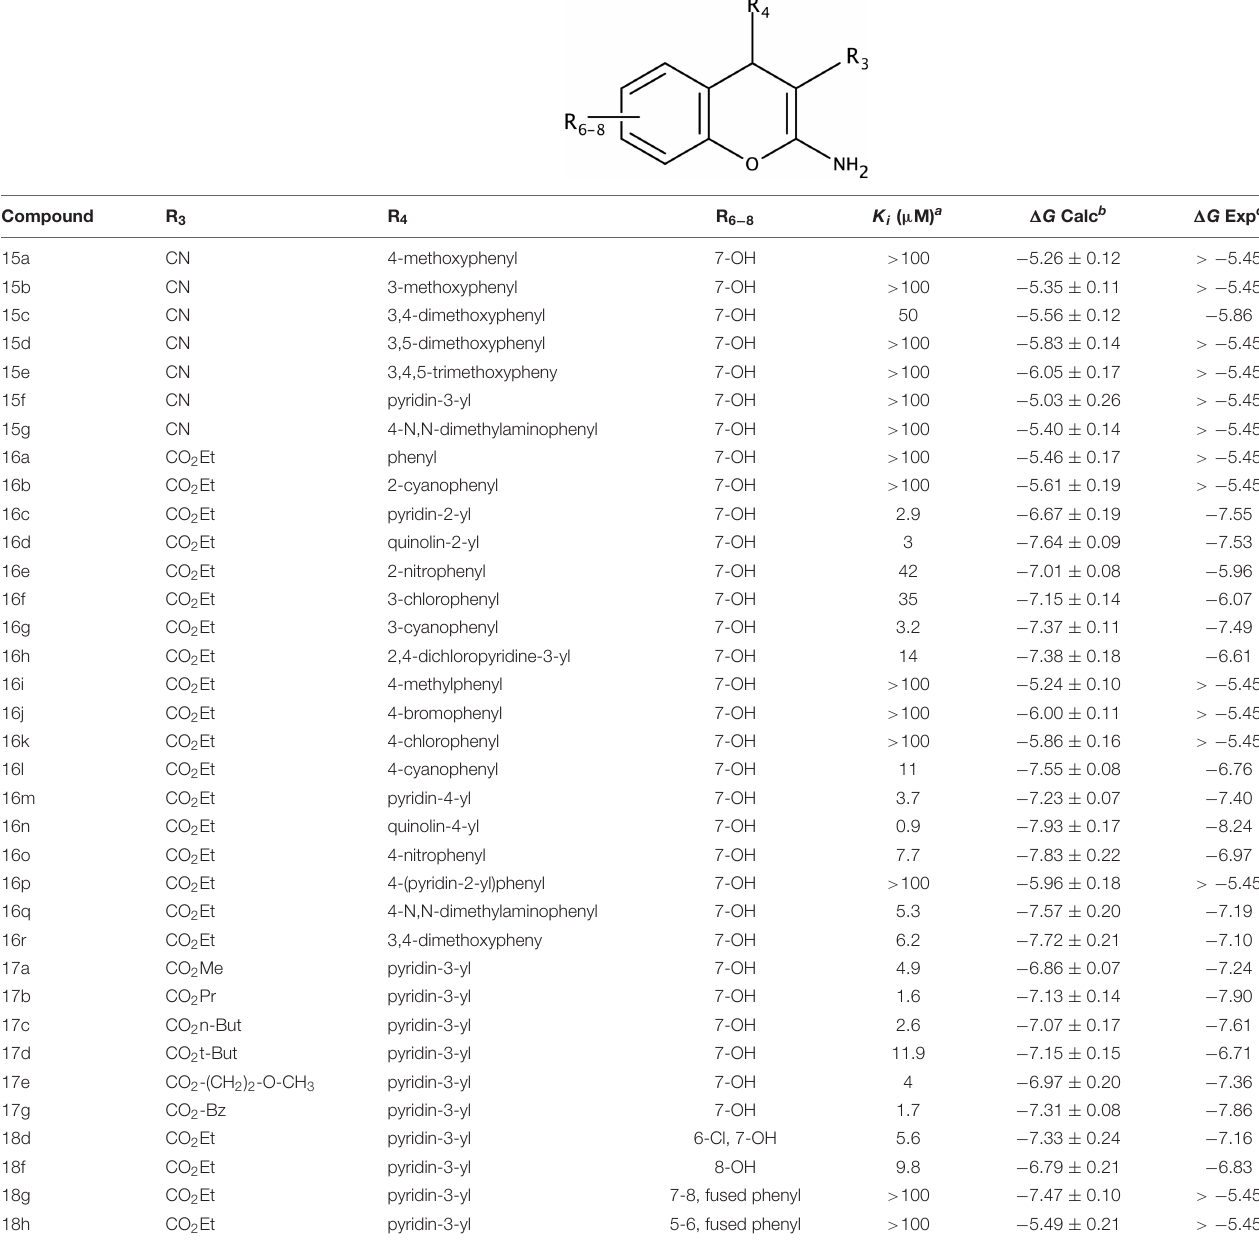
TABLE 1 | LIE-Calculated and experimental binding free energies of HFI-series compounds.